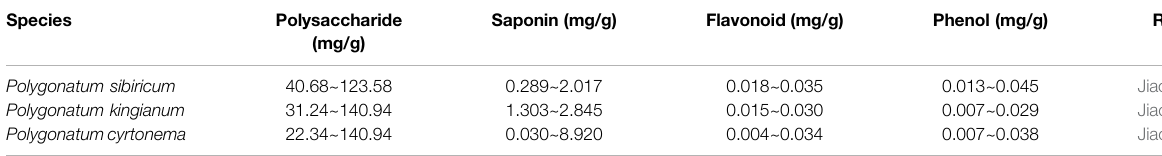
TABLE 1 | Comparison of the major chemical constituents of three Polygonatum spp.